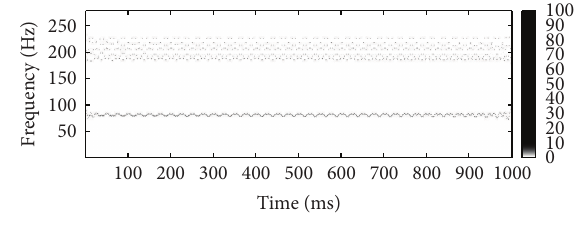
Figure 2: Intensity matrix of Signal 1.